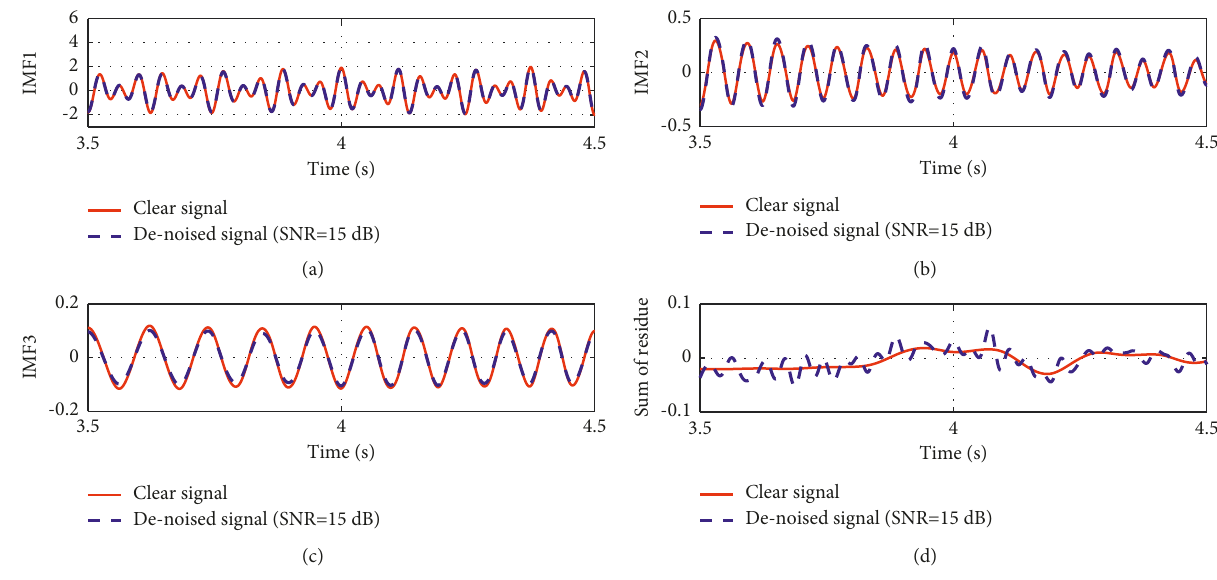
Figure 7: IMFs comparison between clear signal and de-noised signal using proposed method. Table 1: De-noised results in SNR and RMSE of non-stationary signal corrupted by different noise levels. Noise level 10dB 15 dB 20 dB Criteria